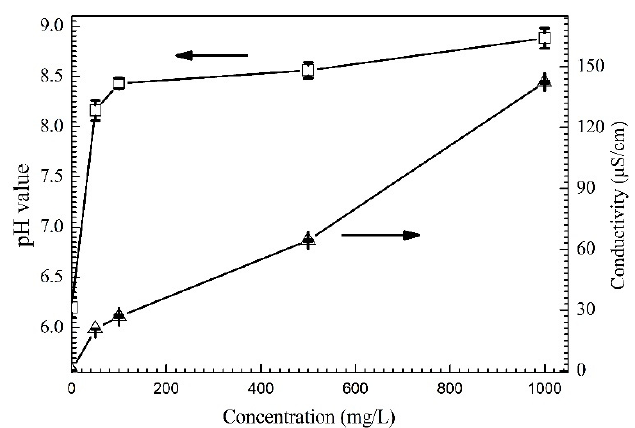
Figure 2. Change of pH value and conductivity with the concentration of Na 2 HPO 4 .